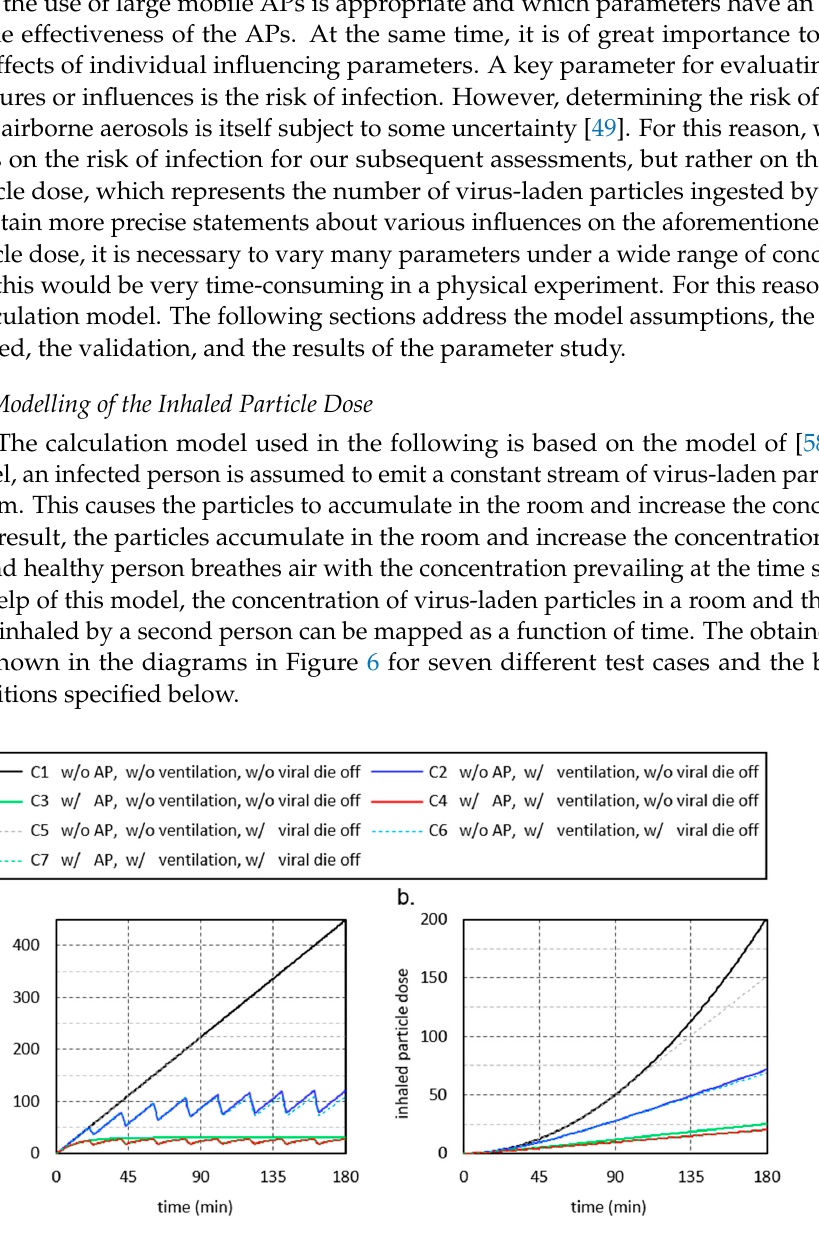
Figure 6. ( a ) Concentration of virus-laden particles in the room over time and ( b ) cumulative number of inhaled virus-laden particles for seven cases. The following conditions are applied: room size 200 m 3 , AP volume flow 1000 m 3 /h, ventilation interval 20 min, ventilation duration 3 min, ventilation air exchange 50%, viral die-off after 90 min.